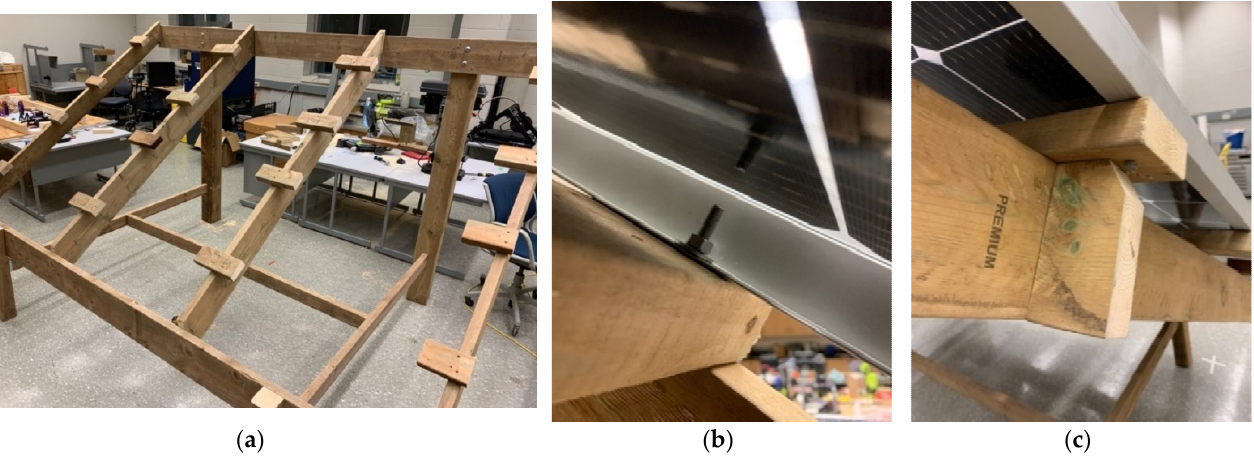
Figure 7. ( a ) Extra lumber made into blocks that line up with the module’s holes, ( b ) a bolt inserted from under and secured with a nut and washer, and ( c ) extra blocks placed under the overhanging block to enhance load transfer to the joist.